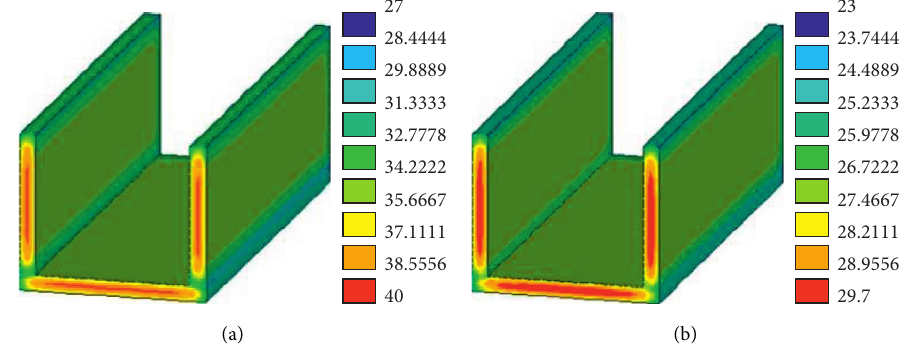
Figure 3: Temperature envelope diagram of center section of BC and IC ( °